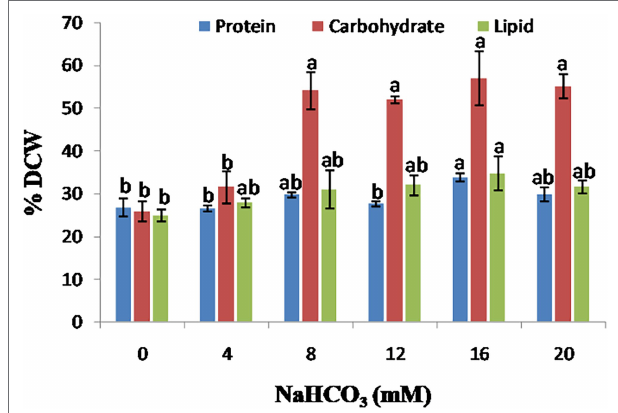
FIGURE 7 | Effect of different sodium bicarbonate concentrations on biochemical composition of microalga Scenedesmus sp. BHU1. Bars are mean ± SE of three replicates. Bars adhered with different alphabets (a and b) are statistically significant at p < 0.05 (Tukey’s-b post hoc test).